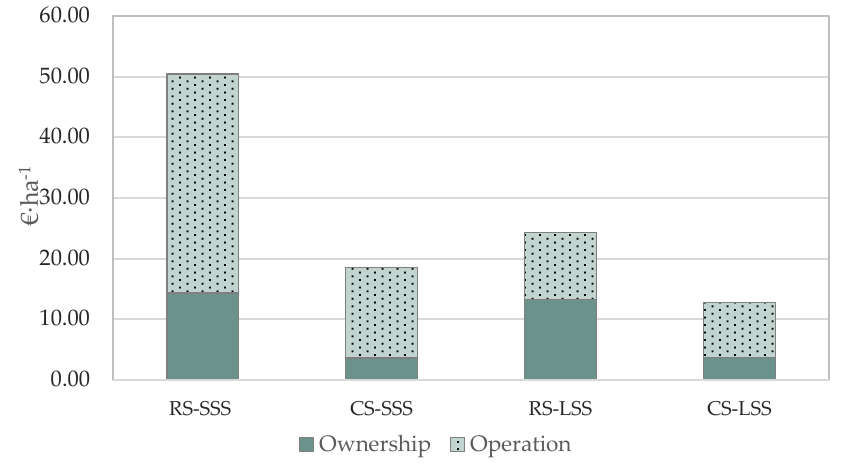
Figure 2. Ownership cost and operation cost contribution to total cost (RS—Robotic System; CS—Conventional System; SSS—Small-Scale Scenario; LSS—Large-Scale Scenario).